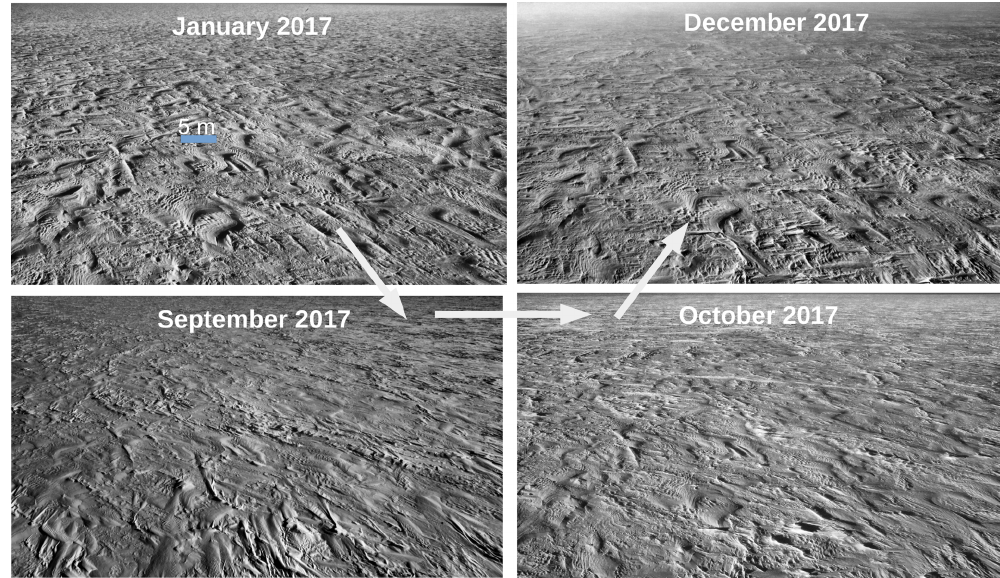
Figure 14. Photographs in the near infrared range (820nm) taken from 20m height at Dome C (75 ◦ S, 123 ◦ E) in Antarctica on 27 Jan- uary 2017 (21:00UTC), 21 September 2017 (06:00UTC), 23 October 2017 (20:00UTC), and 4 December 2017 (17:00UTC) and highlight- ing how little the surface can have changed over nearly 1